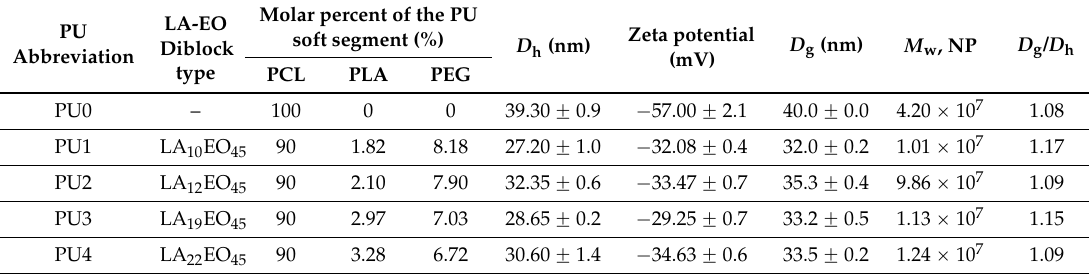
Table 1. The soft segment composition, hydrodynamic diameter ( D h ), diameter of gyration ( D g ), zeta potential and molecular weight of polyurethane (PU) NPs. PCL, poly( ε